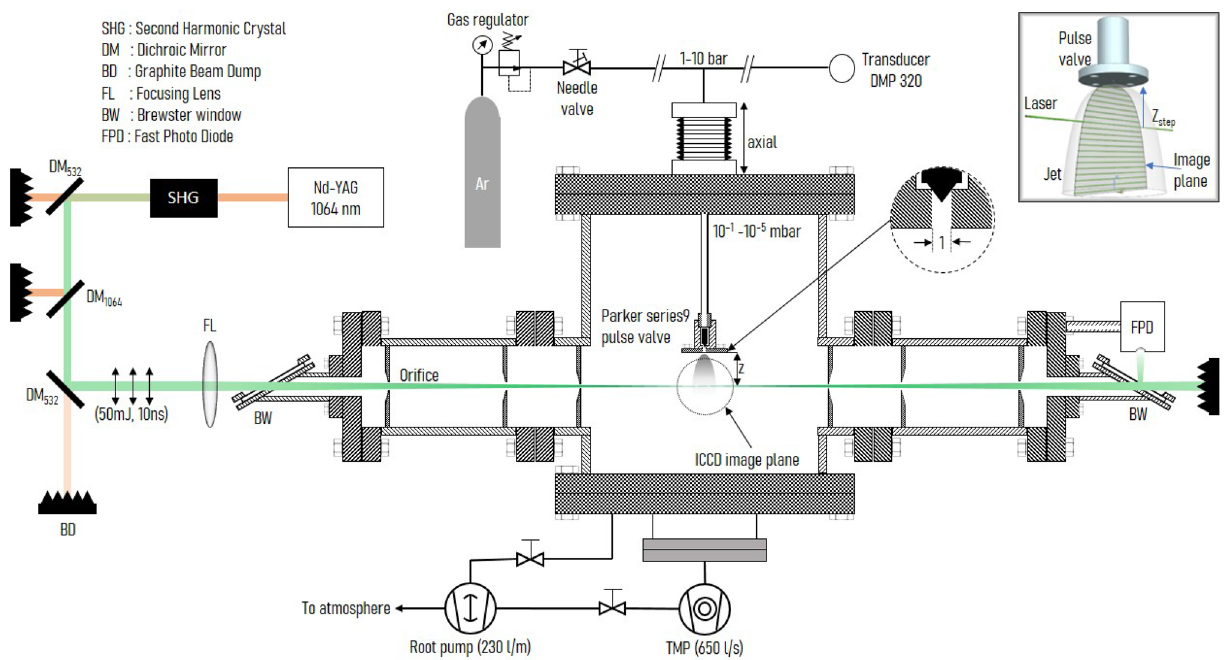
Figure 1. Schematic view of the experimental setup used to generate spatial profile of clusters in the argon jet. Top-right inset shows the scanning technique used to generate 2D profiles of the cluster